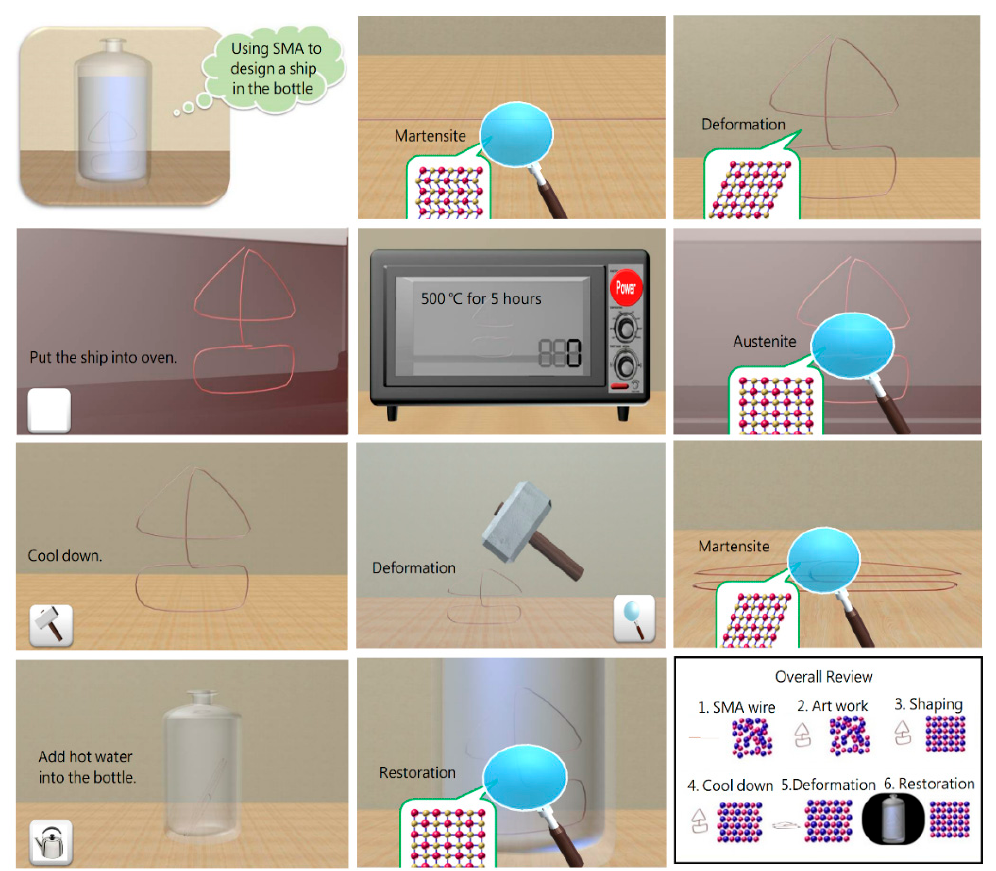
Figure 12. Virtual experiment: designing a ship in a bottle using the SMA wire.